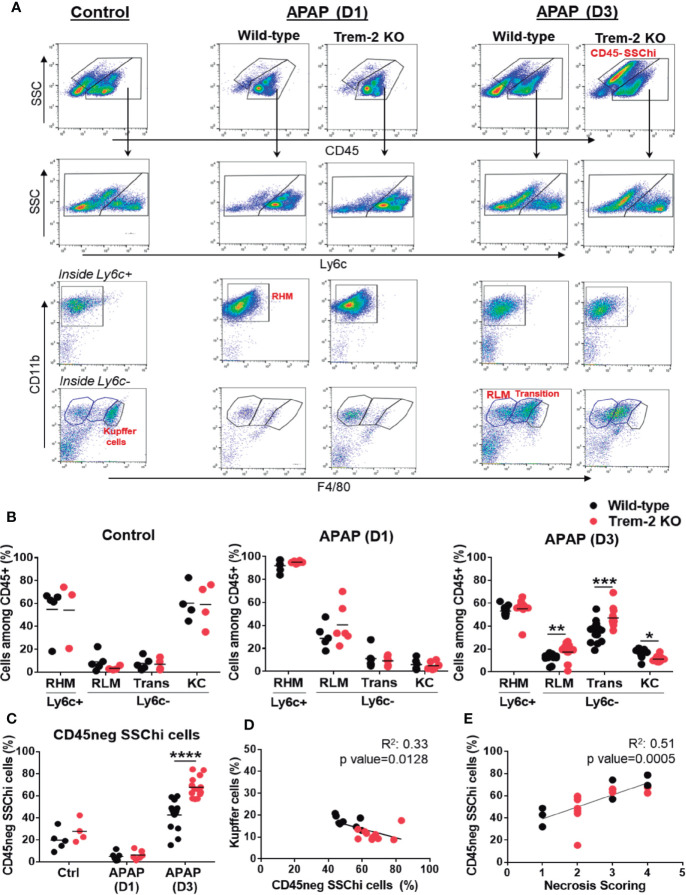
Impaired KC replenishment upon acute liver injury in Trem-2 KO mice and accumulation of non-hematopoietic CD45neg SSChi cells. Flow cytometry analysis of liver non-parenchymal cells (NPCs) from wild-type and Trem-2 KO mice (control versus D1 versus D3) revealed distinct macrophage populations and a non-hematopoietic cell population (CD45neg SSChi). Among macrophages we identified Ly6c+ recruited hepatic macrophages (RHM, CD45+ Ly6c+ F4/80low CD11b+) and Ly6c- macrophages, namely, Kupffer cells (KC, CD45+ Ly6c- F4/80high CD11bint); transition macrophages (Trans, CD45+ Ly6c- F4/80int CD11bhigh); and recruited-like macrophages (RLM, CD45+ Ly6c- F4/80low CD11b+) (A). Cell frequencies of macrophage populations (B) and non-hematopoietic CD45neg SSChi population (C) in control, APAP-D1 and APAP-D3 wild-type and Trem-2 KO mice. Inverse correlation of KC frequency with CD45neg SSChi population at APAP-D3 (D). Correlation of CD45neg SSChi cells frequency with necrosis scoring at APAP-D3 (E). Symbols represent values from individual mice (n=6-11 mice/group). Group mean values are presented. Statistics: Two-way ANOVA in (B, C) Pearson’s correlation test in (D, E) *, p<0.05 **, p<0.01 ***, p<0.001 ****, p<0.0001.